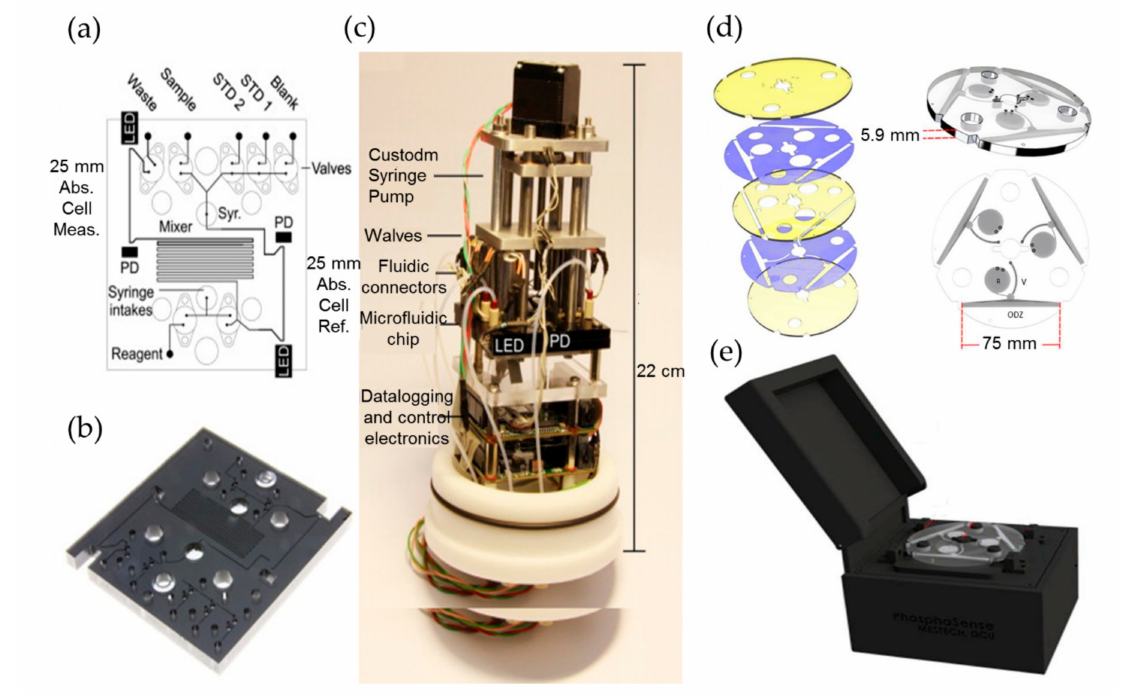
Figure4. Theoptofluidicchipsandassembledsystemusedforphosphatedetection.( a – c